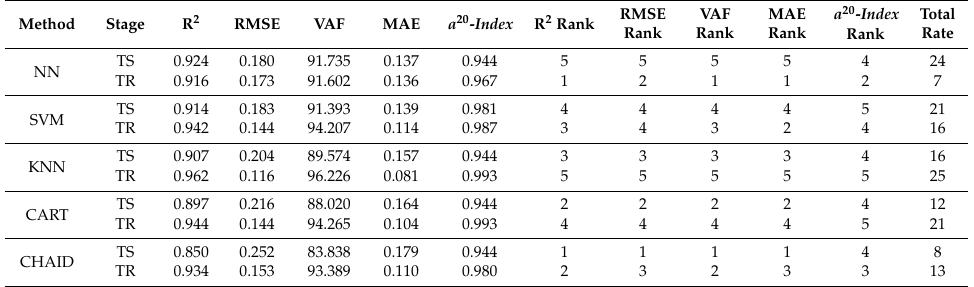
Table 4. The obtained results of performance indices for all predictive models in estimating TBM PR.